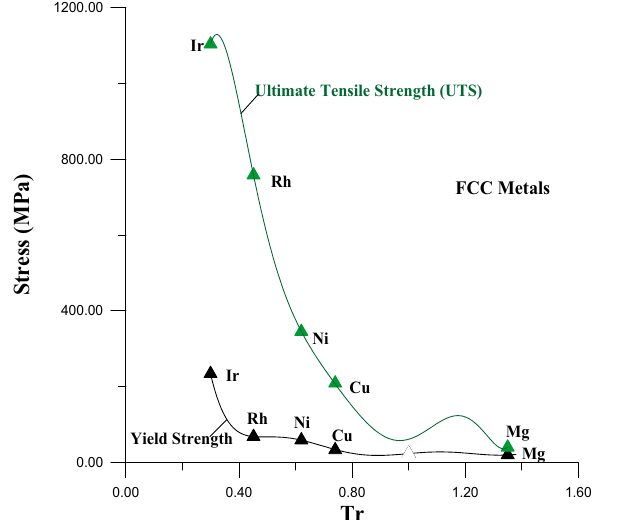
Figure 1. Relationship of UTS and YS with Tr for FCC metals.